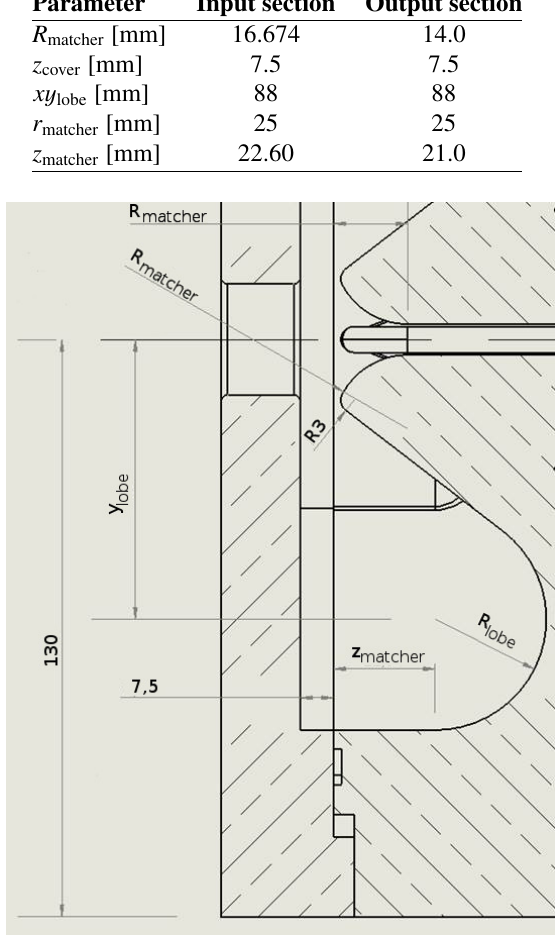
Figure 12. Schematics of the input undercut section of the RFQ, showing the parameters chosen for